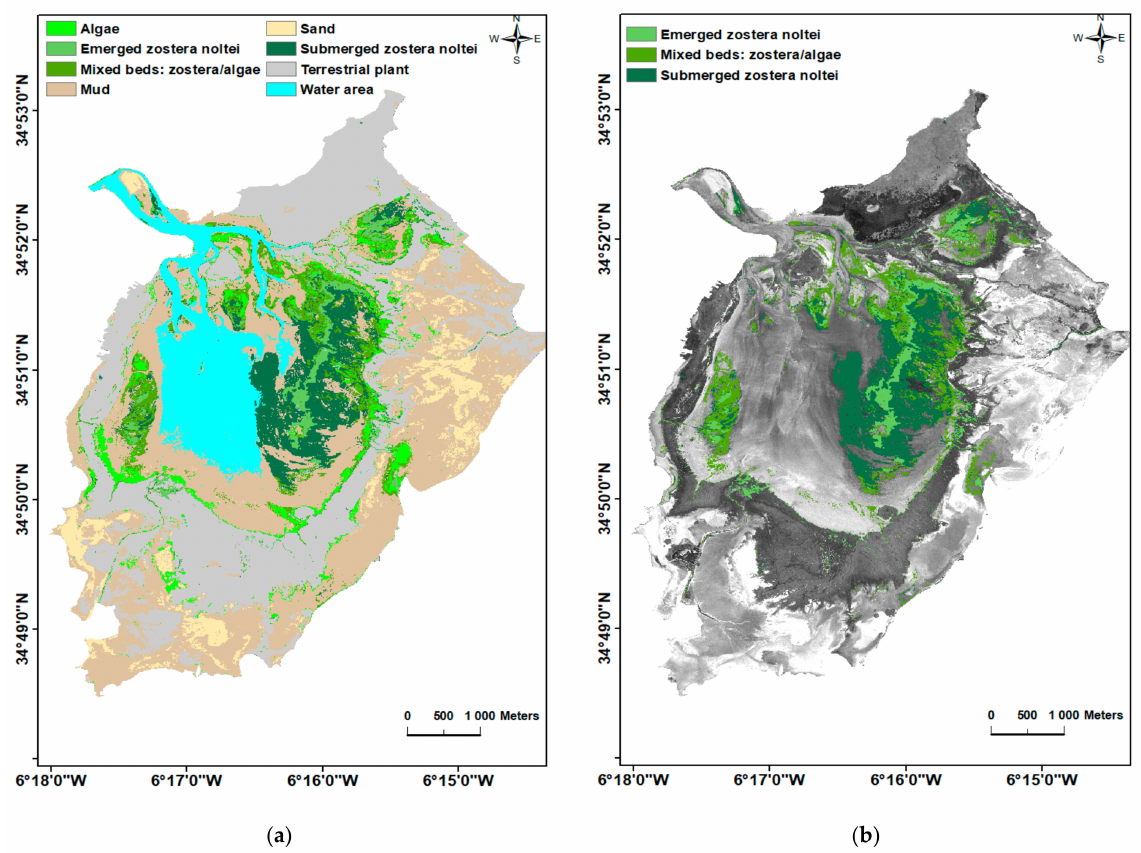
Figure 7. ( a ) Random forest classification results and ( b ) the distribution of dwarf eelgrass Z. noltei and macroalgae in Moulay Bousselham